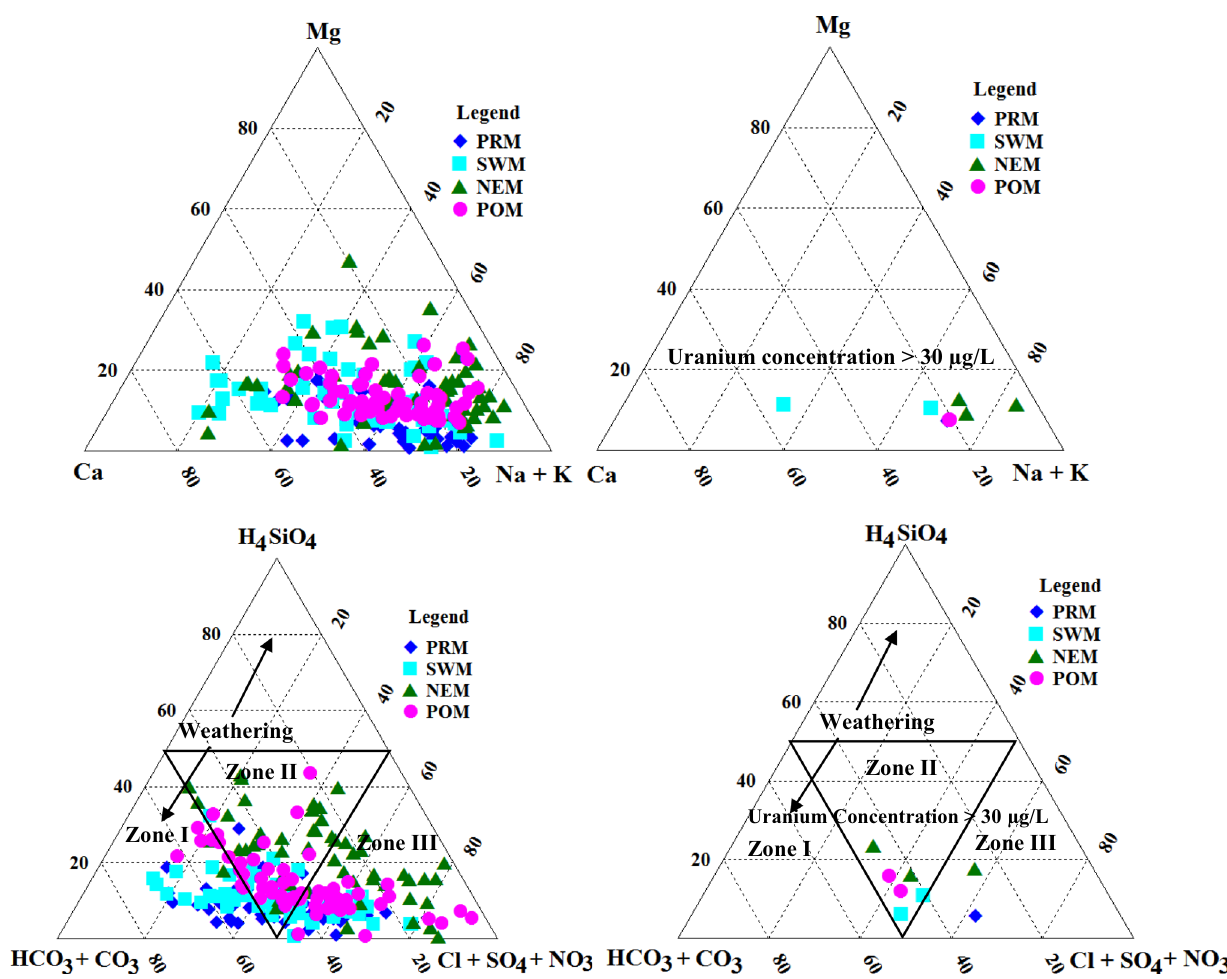
Fig. 12 Ternary plots for major ions to determine geochemical nature of samples with hihger U